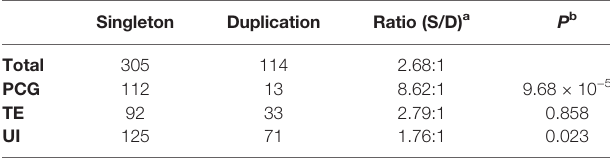
TABLE 1 | Statistical analysis of singleton-to-duplicate ratios of miRNA genes located in three categories of genomic components.